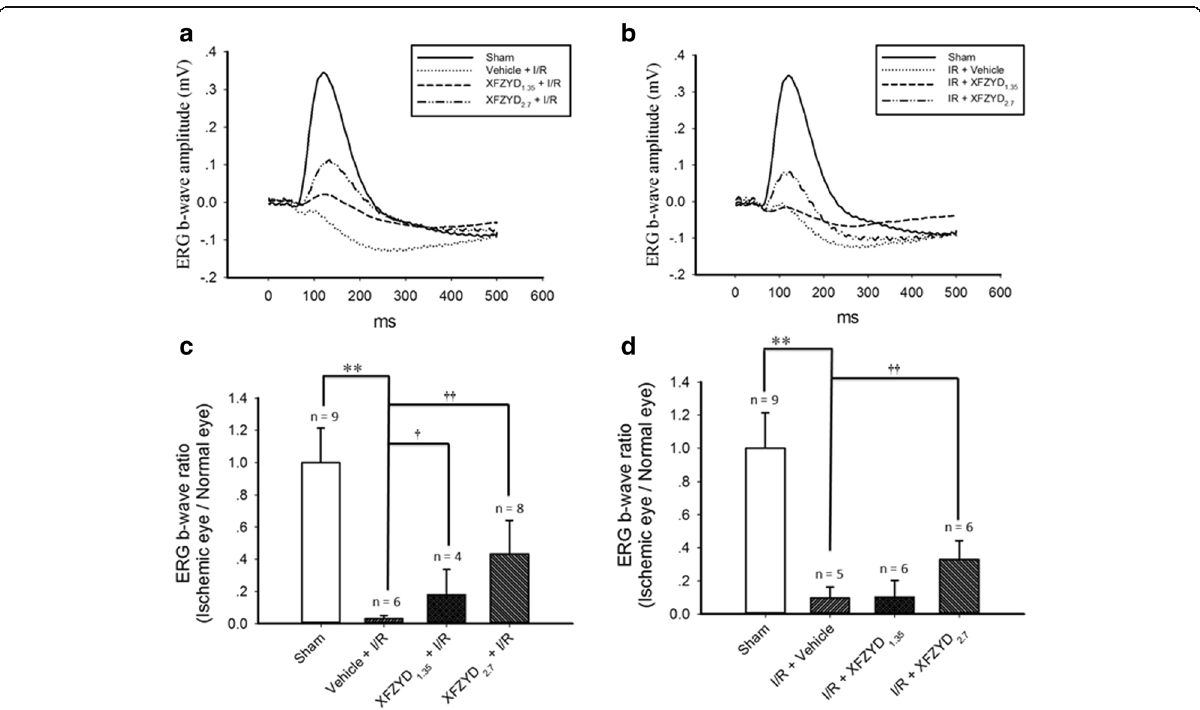
Fig. 1 Electroretinogram (ERG): the influence of preischemia administration or postischemia administration of XFZYD on retinal ischemia. In comparison with the sham retina (Sham), the b-wave amplitude was considerably reduced after pressure-induced retinal ischemia plus reperfusion and preischemia administration (Vehicle + I/R; 1 a ) or postischemia administration of Vehicle (I/R + Vehicle; 1 b ) in a representative rat. This reduction was attenuated dose-dependently by preischemia administration (at 1.35 g/kg/day, XFZYD 1.35 + I/R; at 2.7 g/kg/day, XFZYD 2.7 + I/R, 1 a ) or postischemia administration of XFZYD (at 1.35 g/kg/day, I/R + XFZYD 1.35 ; at 2.7 g/kg/day, I/R + XFZYD 2.7 , 1 b ) in one animal of each relevant group. As compared with the Sham group, a significant (**, p < 0.01) decrease in b-wave ratio was revealed for the Vehicle + I/R (1 c ) or I/R + Vehicle (1 d ) group following pressure-induced retinal ischemia. This ischemia-induced decrease was alleviated in a dose responsive and significant manner ( † , p < 0.05; †† , p < 0.01, 1 c ) by the preischemia administration of 1.35 and 2.7 g/Kg/day of XFZYD. Postischemia administration of XFZYD at 2.7 g/Kg/day (1 d ) also significantly ( †† , p < 0.01) alleviated the reduction. The data are shown as mean values ± SD. XFZYD, Xue-Fu-Zhu-Yu